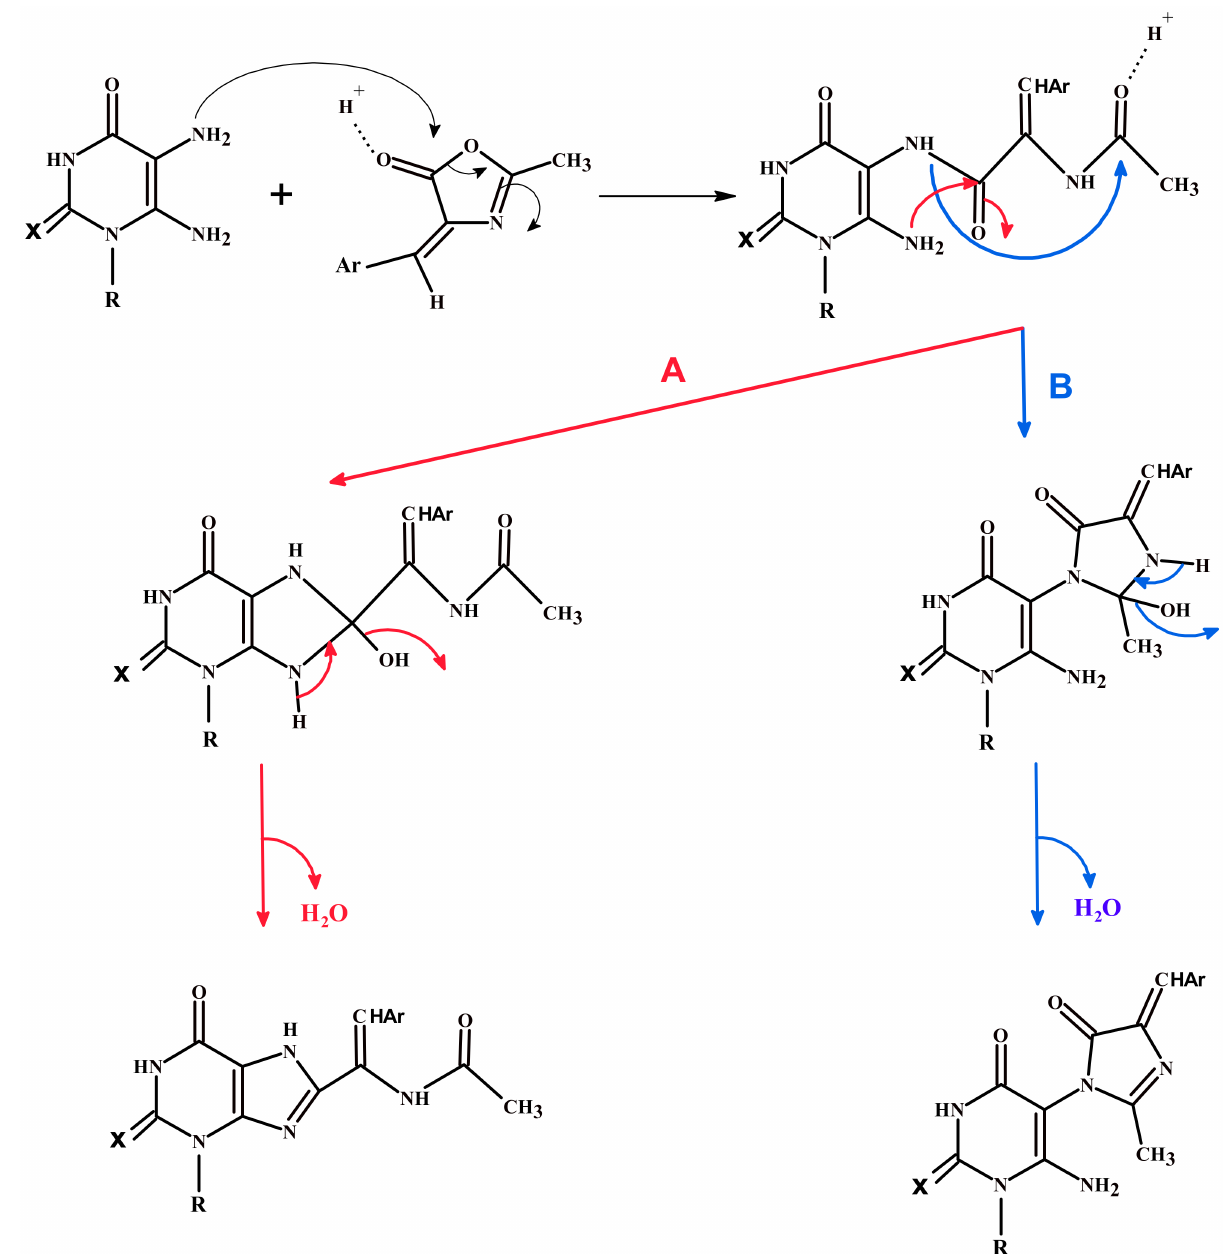
Scheme 5. The suggested mechanism for the synthesis of xanthine and imidazolone